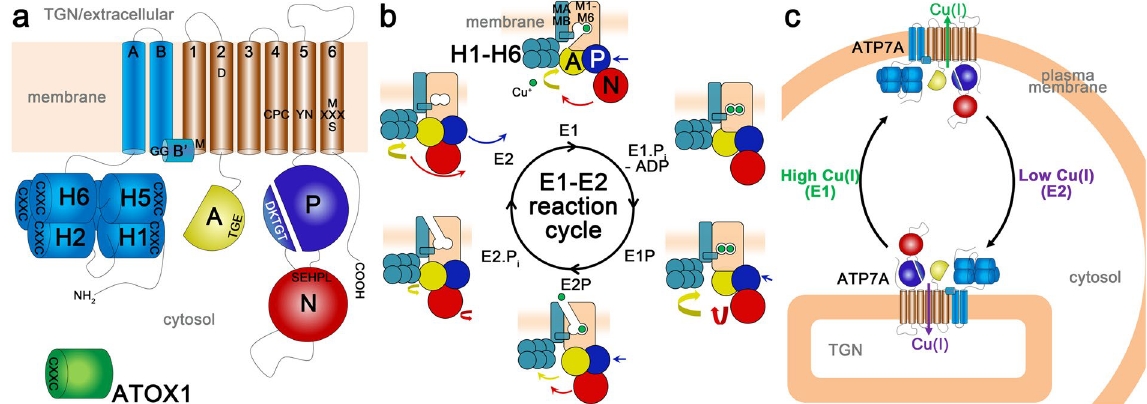
Figure 1. Topology and reaction cycle of ATP7A. ( a ) Topology of ATP7A. ATP7A, and other P-type ATPases consist of three cytoplasmic domains, nucleotide binding (N, red), phosphorylation (P, blue) and dephosphorylation/actuation (A, yellow). The transmembrane domain encompasses eight membrane- spanning segments (TM), two class I specific (TMA-TMB, cyan) and six conserved segments (TM1-6, wheat). The N-terminus contains six class-specific metal-binding domains (H1-H6, cyan). The copper-donating chaperone ATOX1 (green) and conserved motifs are shown. The non-cytosolic part of ATP7A is located in the TGN or in the extracellular milieu, due to copper-dependent trafficking. ( b ) The Albers-Post (E1-E2) reaction cycle of ATP7A and other Cu-transporting P-type ATPases. The domains are colored as described above, and copper ions are shown in green. Phosphorylation events in the intracellular domains drive large conformational changes that permit alternating access to transport sites in the membrane about 50 Å from the ATP-targeted catalytic aspartate. A high-affinity state (E1) binds copper and enters an occluded state, which then undergoes phosphorylation (E1.Pi-ADP). Completion of this event (E1P) triggers release of the ion, establishing an outward-facing, low-affinity state (E2P). Release of inorganic phosphate (E2.Pi) yields the fully dephosphorylated conformation (E2), which is followed by restoration of the inward-facing